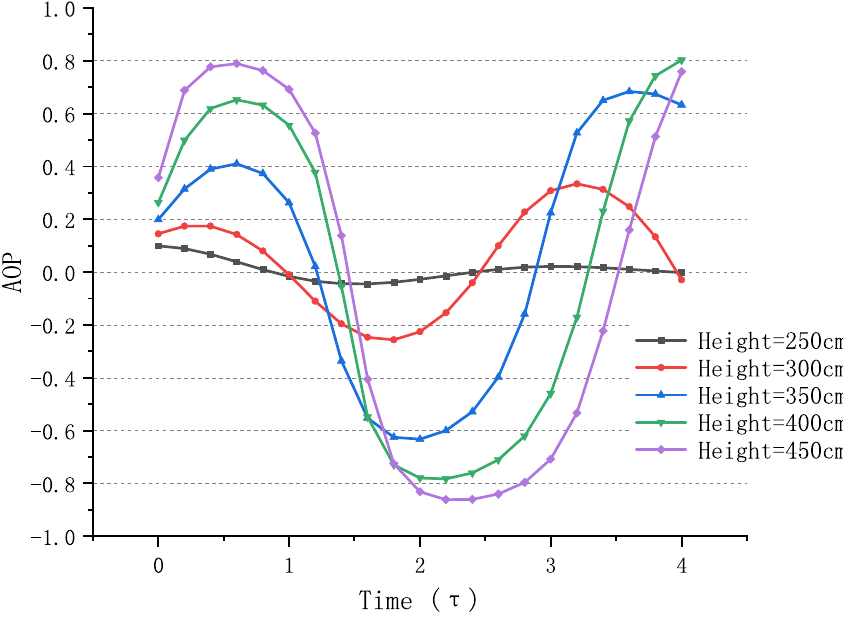
Fig. 3. Evolution of AO p for various values of